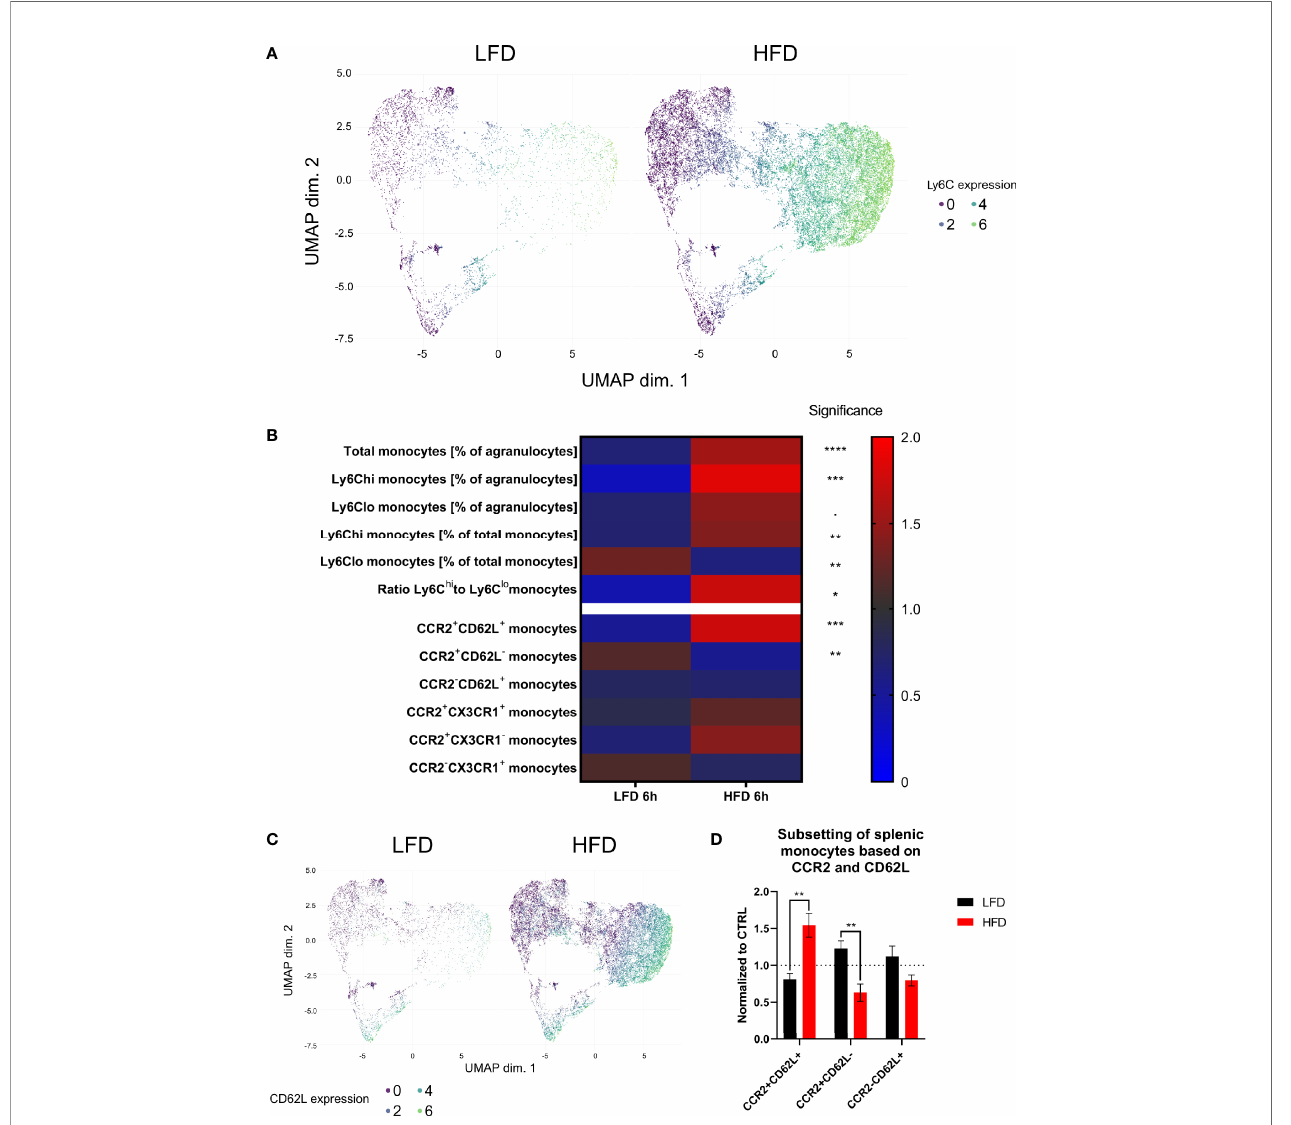
FIGURE 4 | CyTOF analysis of circulating and splenic monocytes 6 h post trauma. Uniform manifold approximation and projection (UMAP) of monocytes (LIN - , CD115 + , CD11b + ) was generated based on the expression of CD115, CD11b, CD62L, Ly6C, CX3CR1, and CCR2 and colored by the expression of LY6C (A) . Heatmap showing various monocytes populations (normalized by ratio to mean) between mice receiving either low-fat diet (LFD) or high-fat diet (HFD) 6 h post trauma (B) . UMAP of monocytes (LIN-, CD115+, CD11b+) was generated based on the expression of CD115, CD11b, CD62L, CX3CR1, and CCR2 and colored by the expression of CD62L (C) . Comparison of splenic monocyte subsets (normalized to CTRL) based on the expression of CCR2 and CD62L between mice receiving either low-fat diet (LFD) or high-fat diet (HFD) 6 h post trauma (D) . Statistics: unpaired two-tailed Student ’ s t -test was used for comparison of lean and obese mice at a speci fi c time point, signi fi cance indicators are displayed above a connector line. ▪ indicates p ≤ 0.1, * indicates p ≤ 0.05, ** indicates p ≤ 0.01, *** indicates p ≤ 0.001, **** indicates p ≤ 0.0001. Sample sizes: LFD 6 h = 6, HFD 6 h = 4. Data are displayed as mean ±